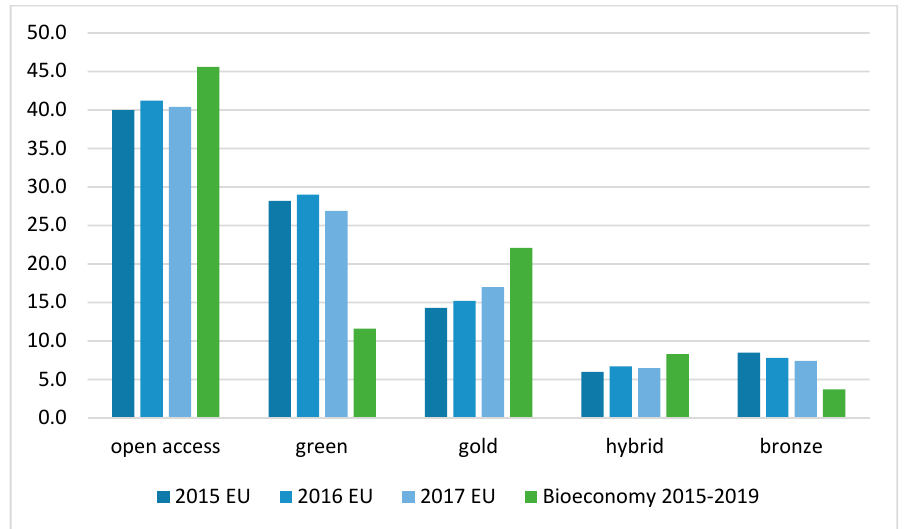
Figure 11. Percentage of open access articles (source for 2015 EU, 2016 EU and 2017 EU: EC Open Science Monitor).